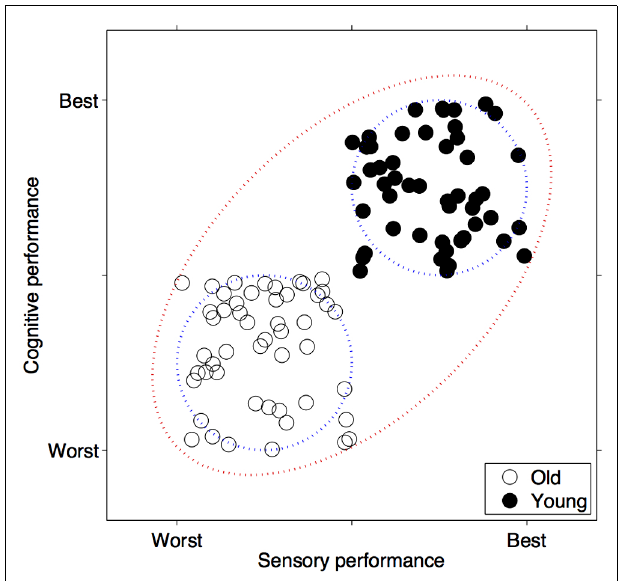
FIGURE 1 | Statistical artifact when correlating sensation and cognition by including the extremes of the age continuum .The graph depicts two hypothetical age groups of subjects characterized by, respec- tively, poor sensory and poor cognitive performance (old) and good sensory and good cognitive performance (young). In the data represented, the correlation between sensory and cognitive performance (blue circles) is null within both groups: respectively r (old) = 0.004 and r (young) = − 0.062. In contrast, regarding the correlation between sensory and cognitive perfor- mance calculated including all participants (red circle), the correlation is strong: r (all) = 0.719.The same artifact affects regression